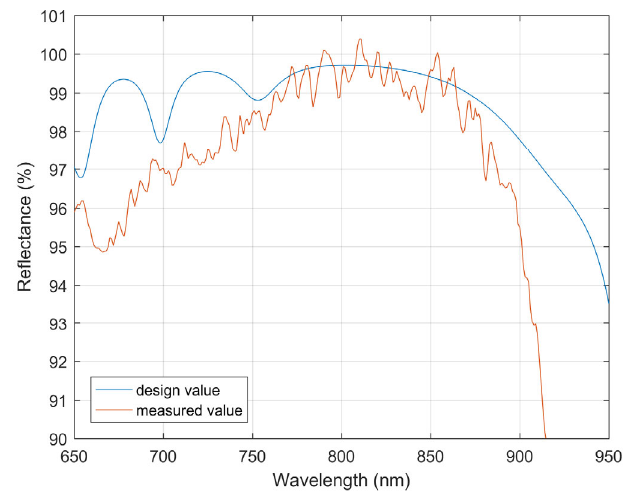
Figure 16. Comparisons of the plots between the measured reflectance and the optimal design values showing an average of 2% extra losses due to scattering.